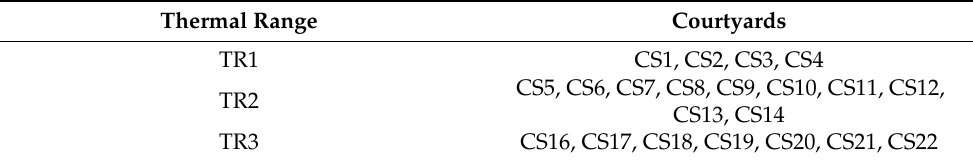
Table 3. Classification of courtyards within temperature range